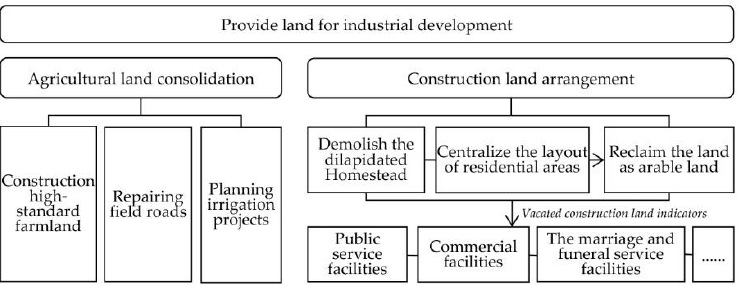
Figure 7. Schematic diagram of providing land for industrial development through agricultural land consolidation and construction land arrangement.